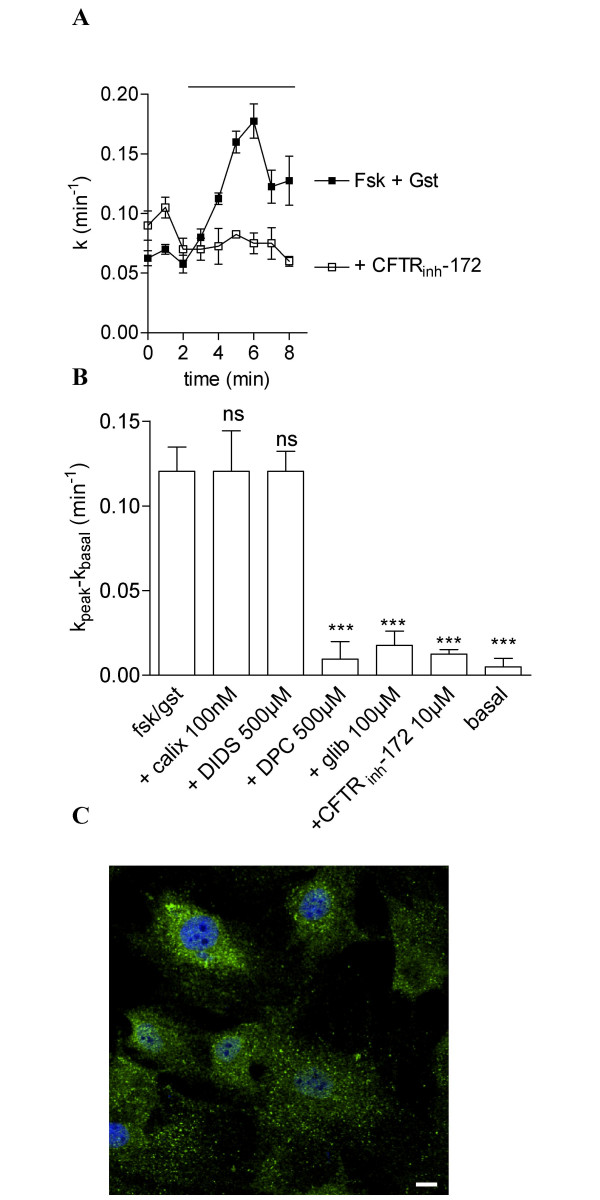
Pharmacological inhibition and immunolocalisation of CFTR in rat tracheal smooth muscle cells. A Iodide efflux response as a function of time evoked by cAMP agonists (10 μM forskolin + 30 μM genistein) and 10 μM CFTRinh-172. B Effect of 100 μM glibenclamide, 500 μM DPC, 500 μM DIDS, 100 nM calixarene and 10 μM CFTRinh-172 on the efflux stimulated by cAMP agonists in rat tracheal smooth muscle cells as indicated. Basal was vehicle alone. Data are presented as mean ± S.E.M. All experimental conditions have been repeated: n = 4. C Immunofluorescence study of CFTR in TSMC and D in the absence of primary antibody. α-smooth muscle actin is stained in red, CFTR in green and nucleus (TOPRO-3 staining) in blue. Scale bars are 10 μm.